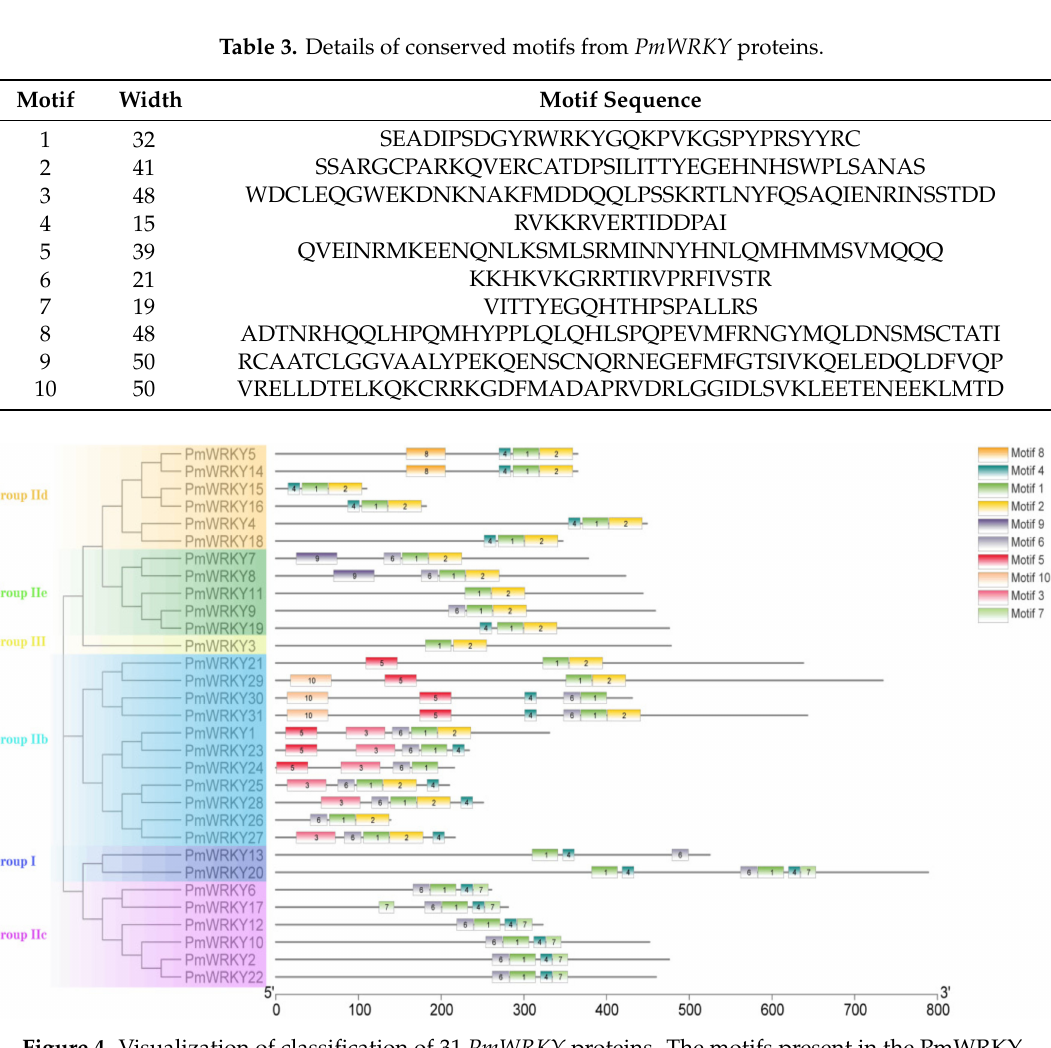
Figure 4. Visualization of classification of 31 PmWRKY proteins. The motifs present in the PmWRKY proteins based on MEME analysis. Architecture of 10 conserved protein motifs in PmWRKY s. Each motif is represented in a di ff erent color (Motif